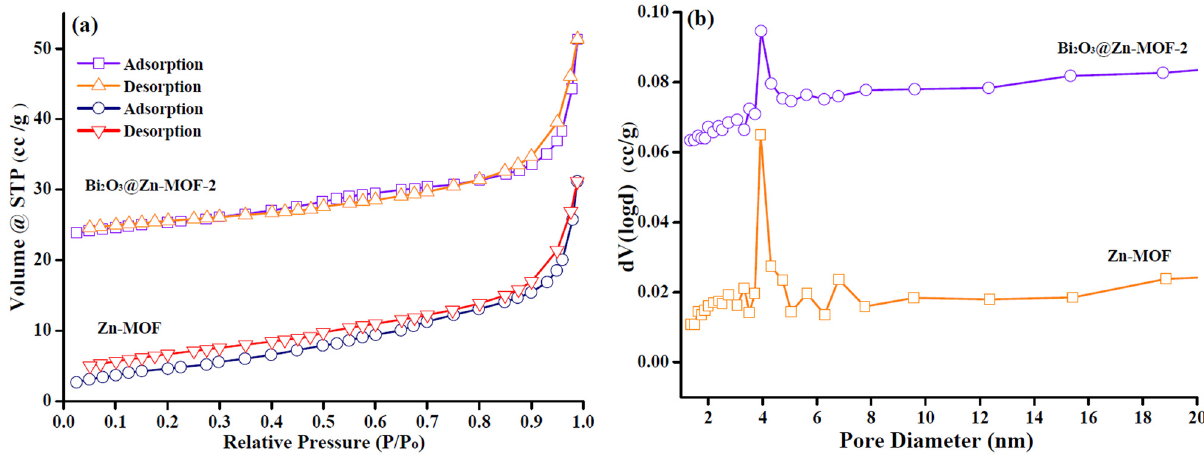
Figure 3: N 2 adsorption – desorption isotherms ( a ) and pore size distribution ( b ) of Zn - MOF and Bi 2 O 3 @Zn - MOF